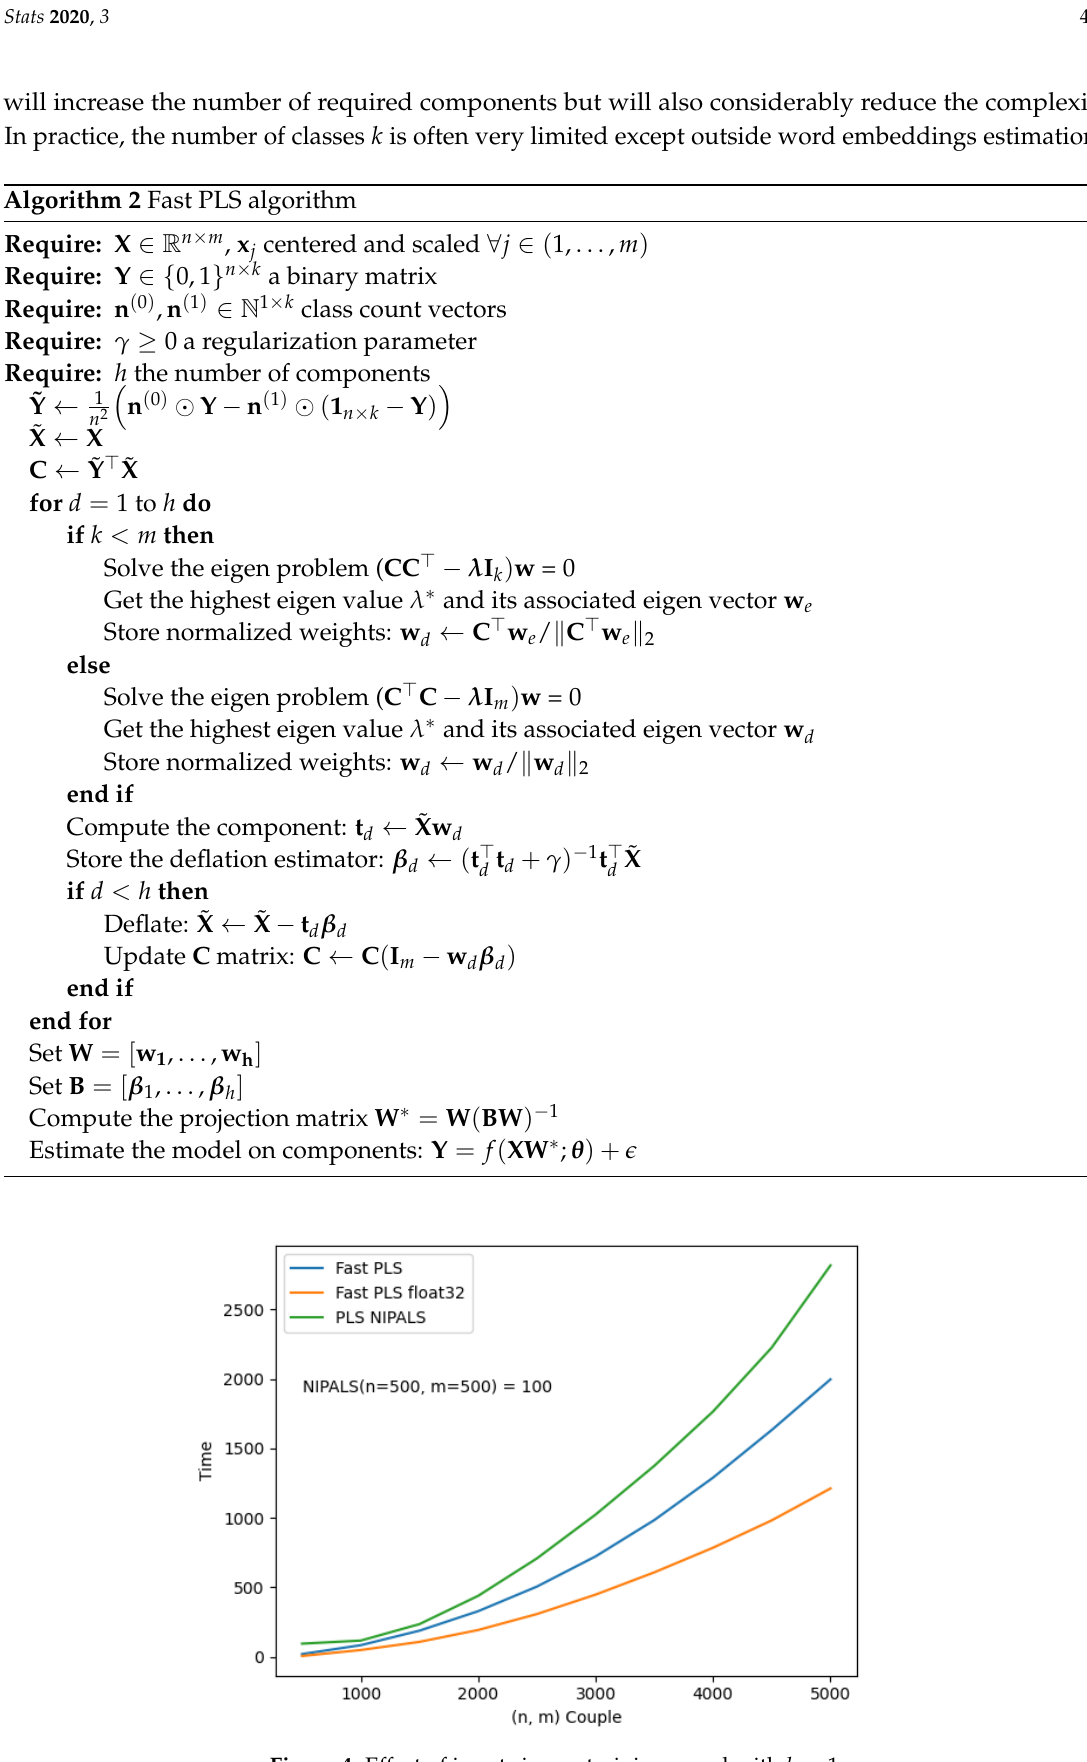
Figure 4. Effect of input size on training speed with k =